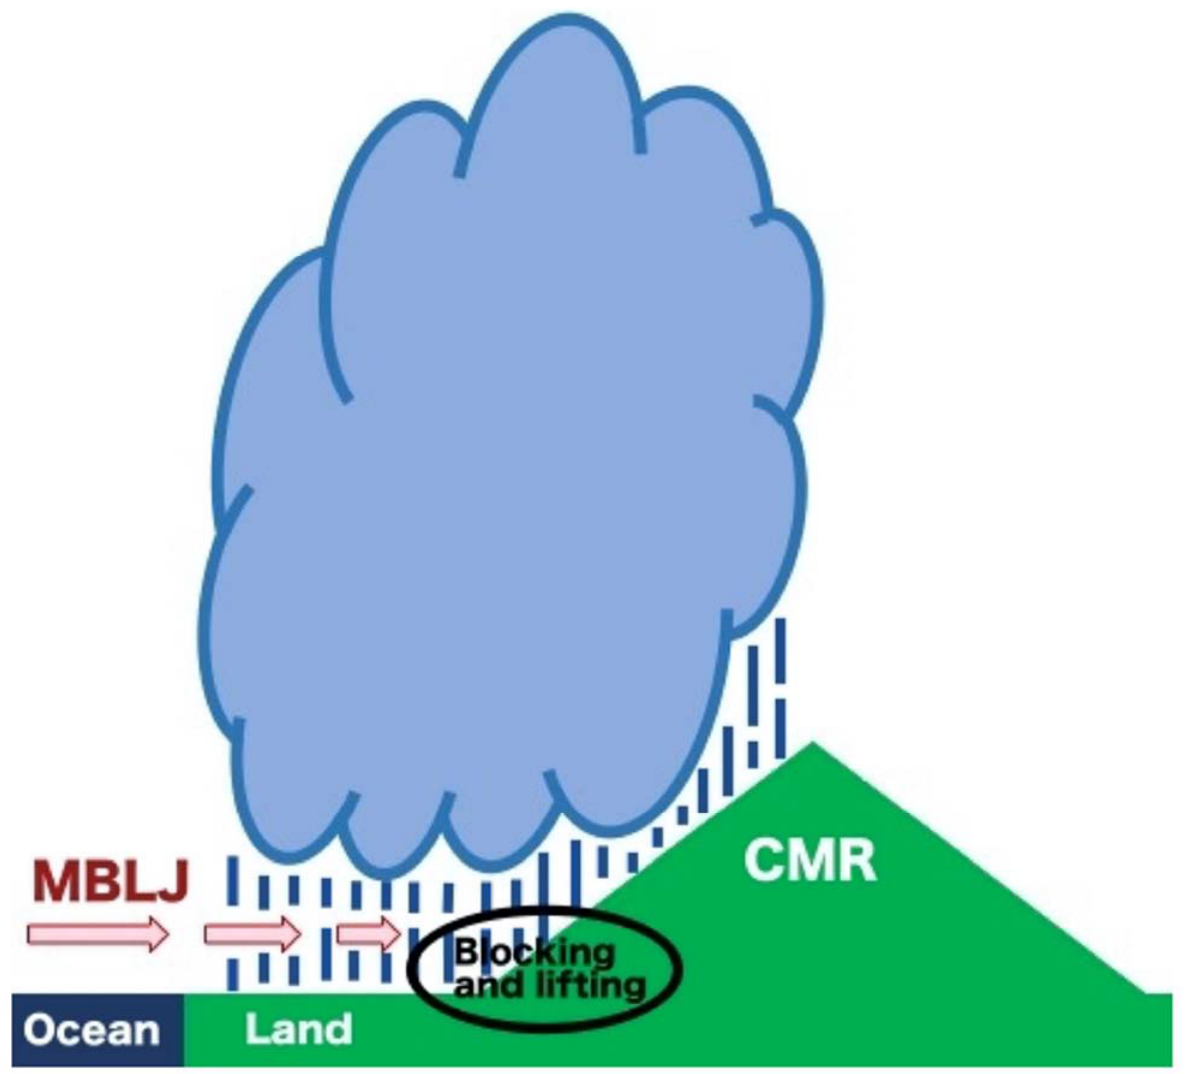
Figure 14. A schematic diagram showing the moisture transport from the NSCS toward Taiwan and rising motion due to flow deceleration, blocking, and lifting by the Central Mountain Range (CMR).